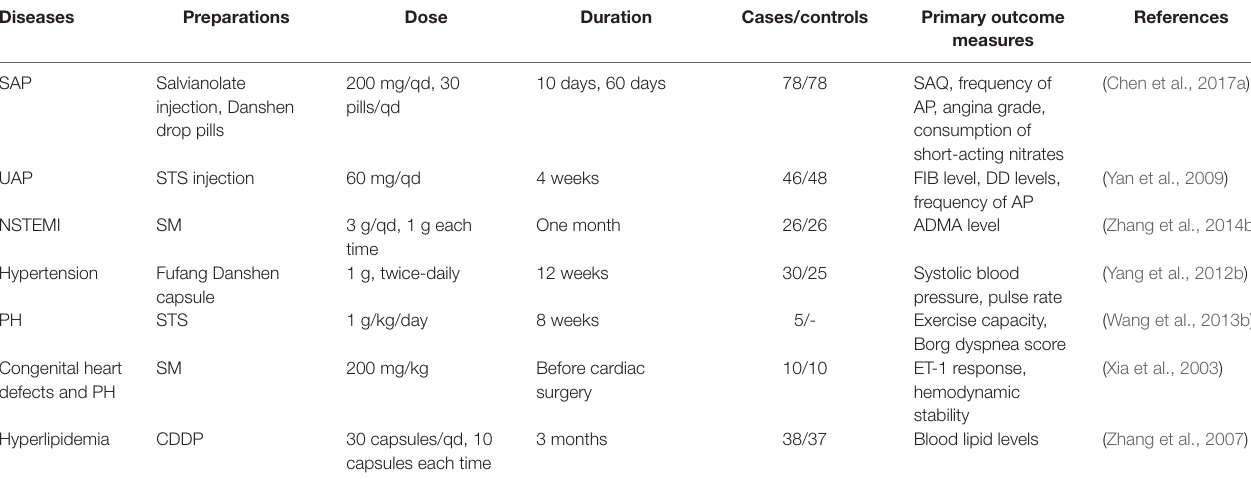
TABLE 3 | Clinical trials of S. miltiorrhiza preparations for controlling cardiovascular